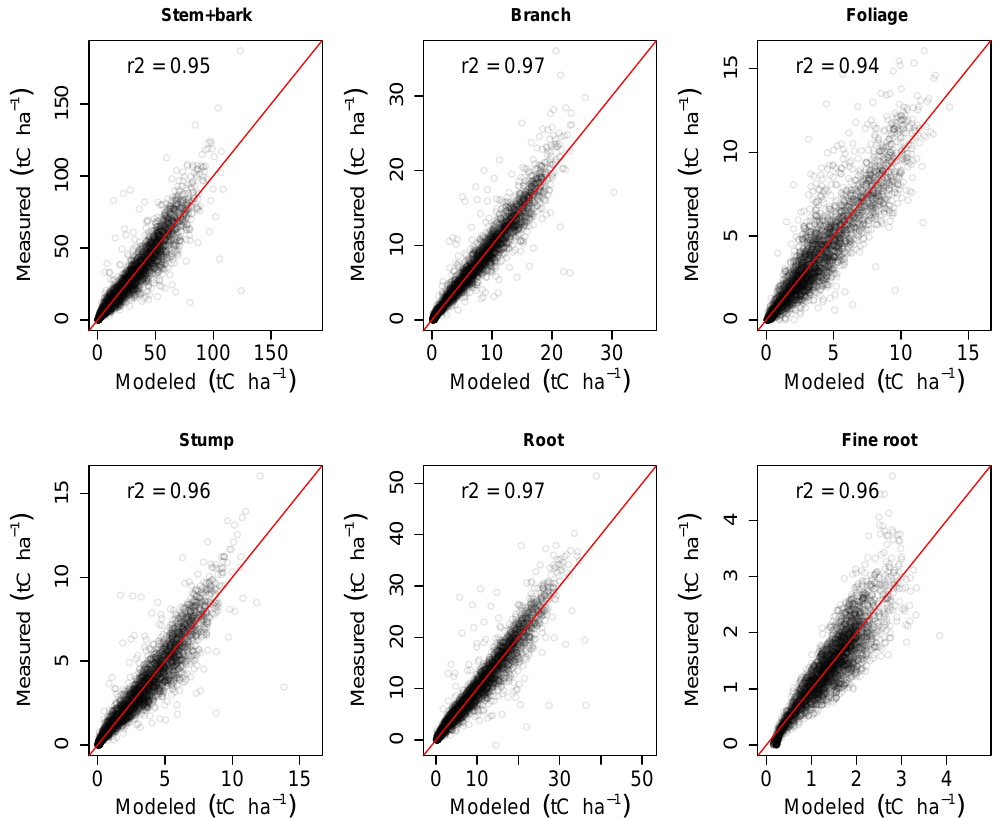
Figure B1. Scatter plots ( n = 3698 in each panel) for the dry weight tree biomass components (tCha − 1 ) between “modeled” (estimated based on fraction of absorbed radiation, f APAR , and our f APAR models) and “measured” (estimated based on basic tree dimensions and allometric biomass models). The r 2 values represent the coefficient of determination indicating how close the modeled values fit the measured